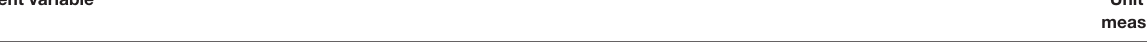
Prevalence of depression in 2010 and 2020 by